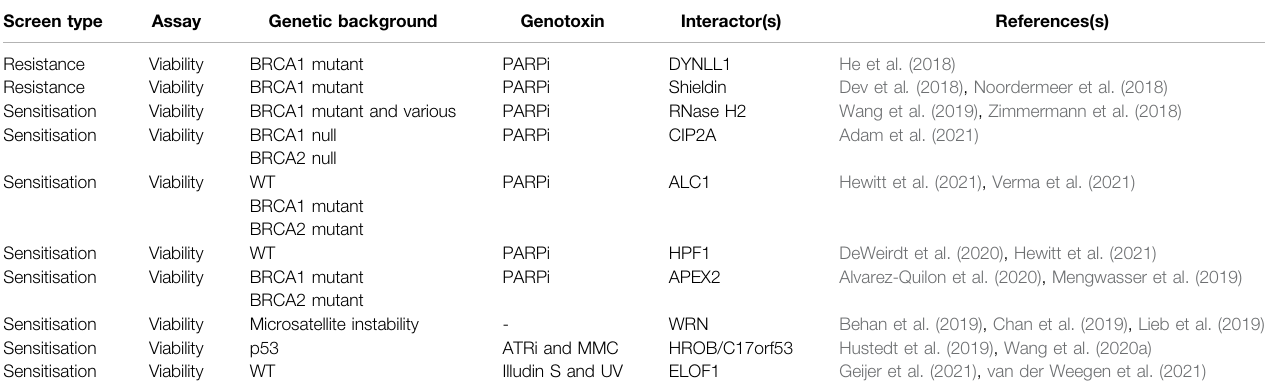
TABLE 1 | Selected DDR (chemo)genetic